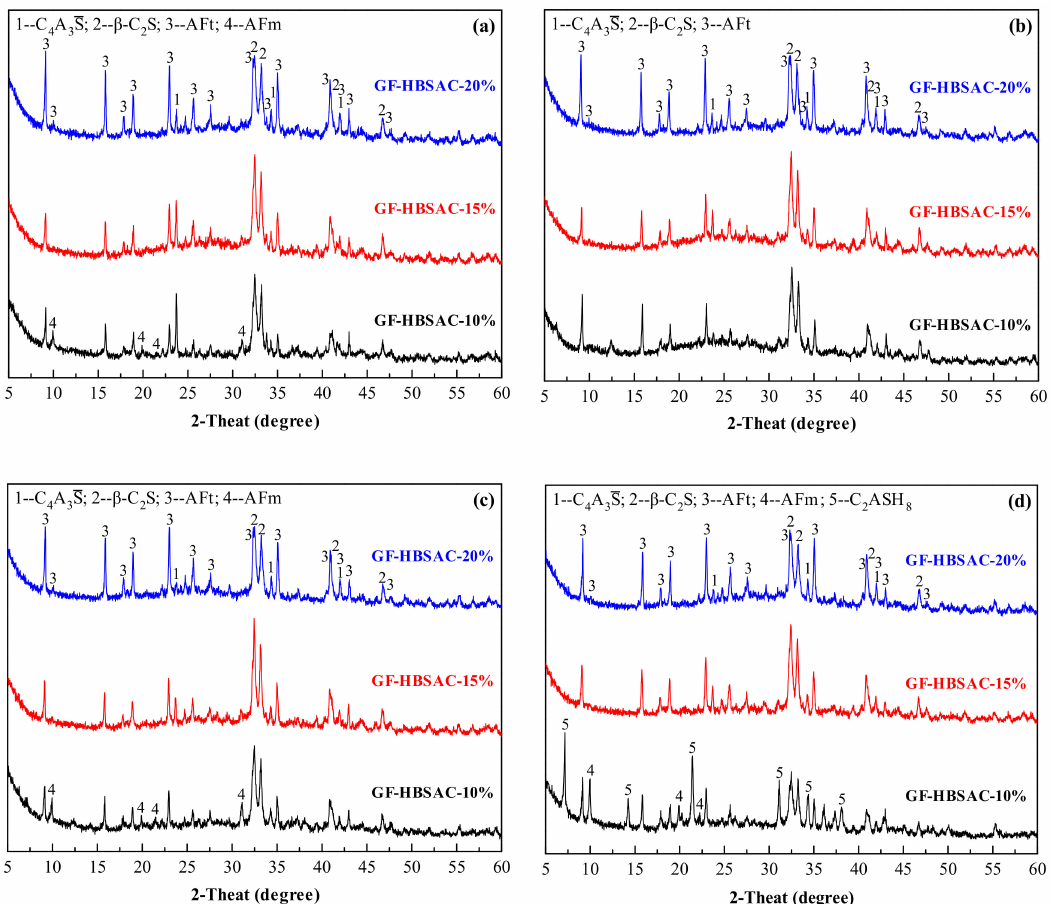
Figure 22. X-ray di ff raction (XRD) patterns of the Series GF-HBSAC-Y cement hydration products at di ff erent curing ages: ( a ) One day; ( b ) 3 days; ( c ) 7 days; ( d ) 28